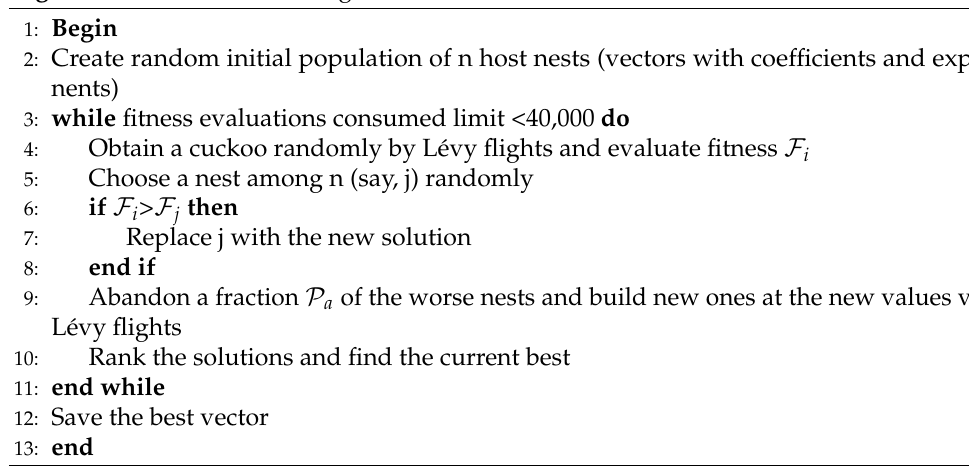
Algorithm 2 Cuckoo search algorithm